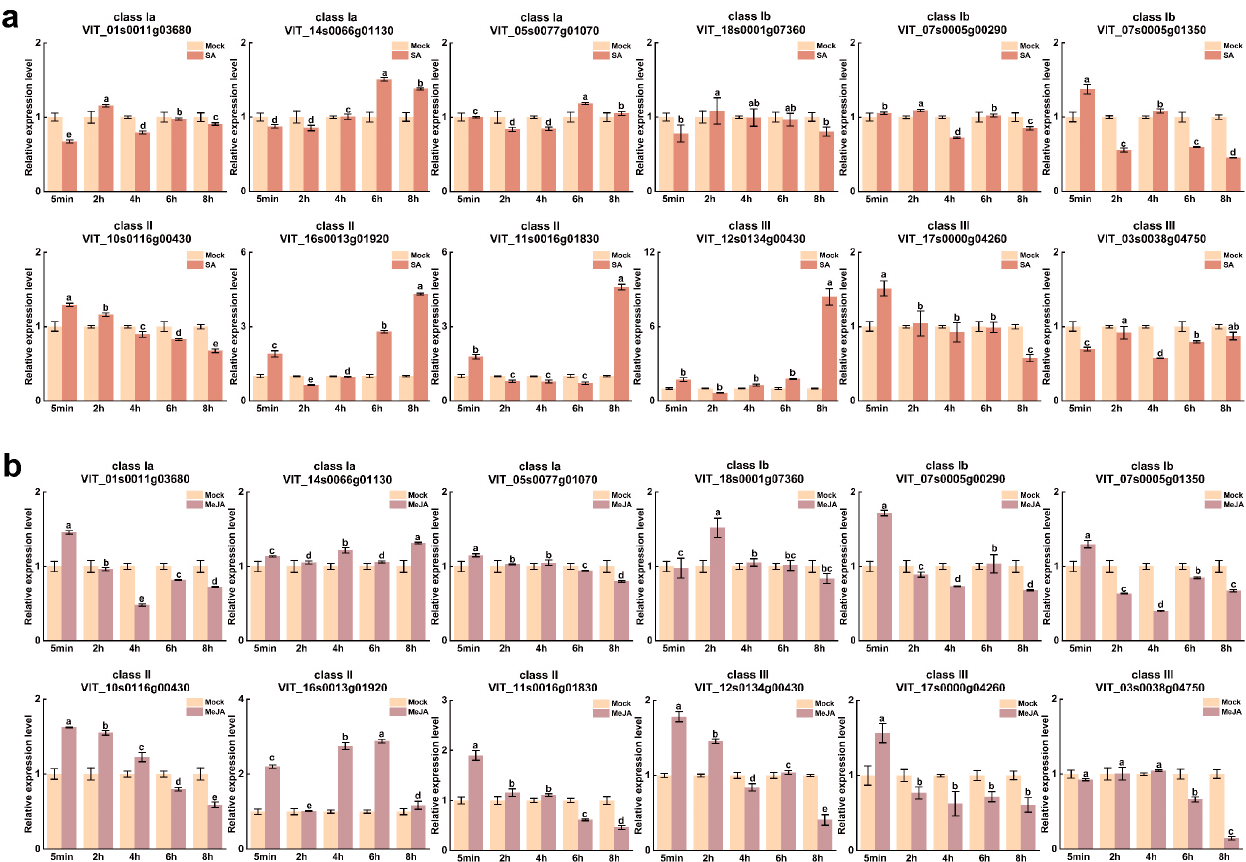
Figure 6. Expression levels of VvUSP genes under SA ( a ) and MeJA ( b ) treatments by qRT-PCR. Different letters above the bars indicate a significant difference ( p < 0.05).